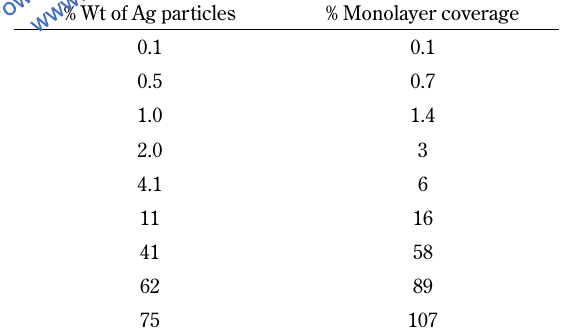
Table 5 Comparison of nano-particles and the percent are occupied on the substrate % Wt of Ag particles